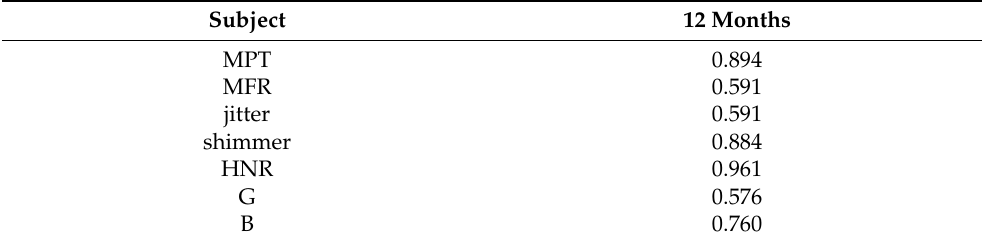
Table 5. p values of each parameter in comparison between shaving and normal-reconstruction subgroups.